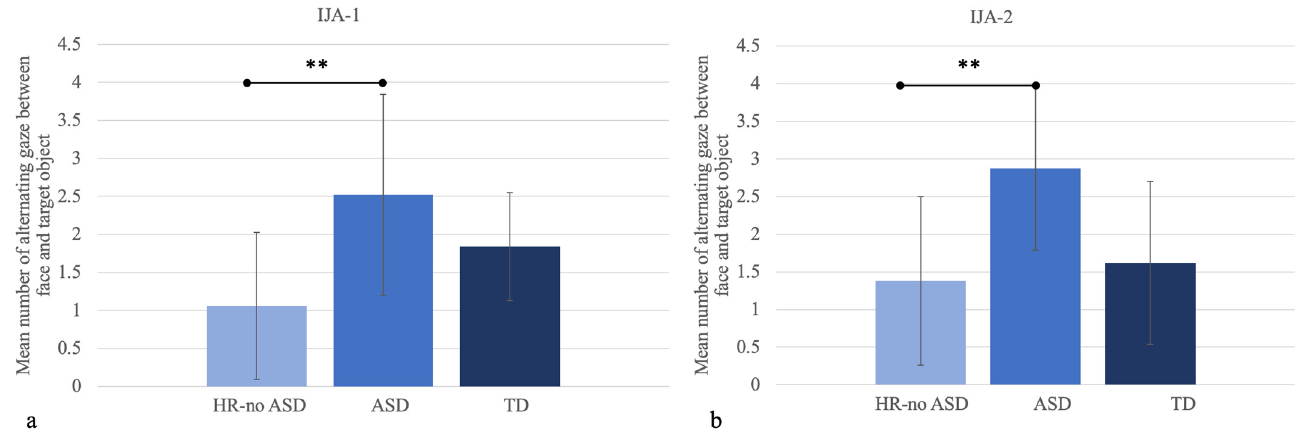
Figure 1. Number of gaze alternations made between the model’s face and the target object in IJA- 1 ( a ) and IJA-2 ( b ). Error bars represent standard deviations. ** p < 0.001.